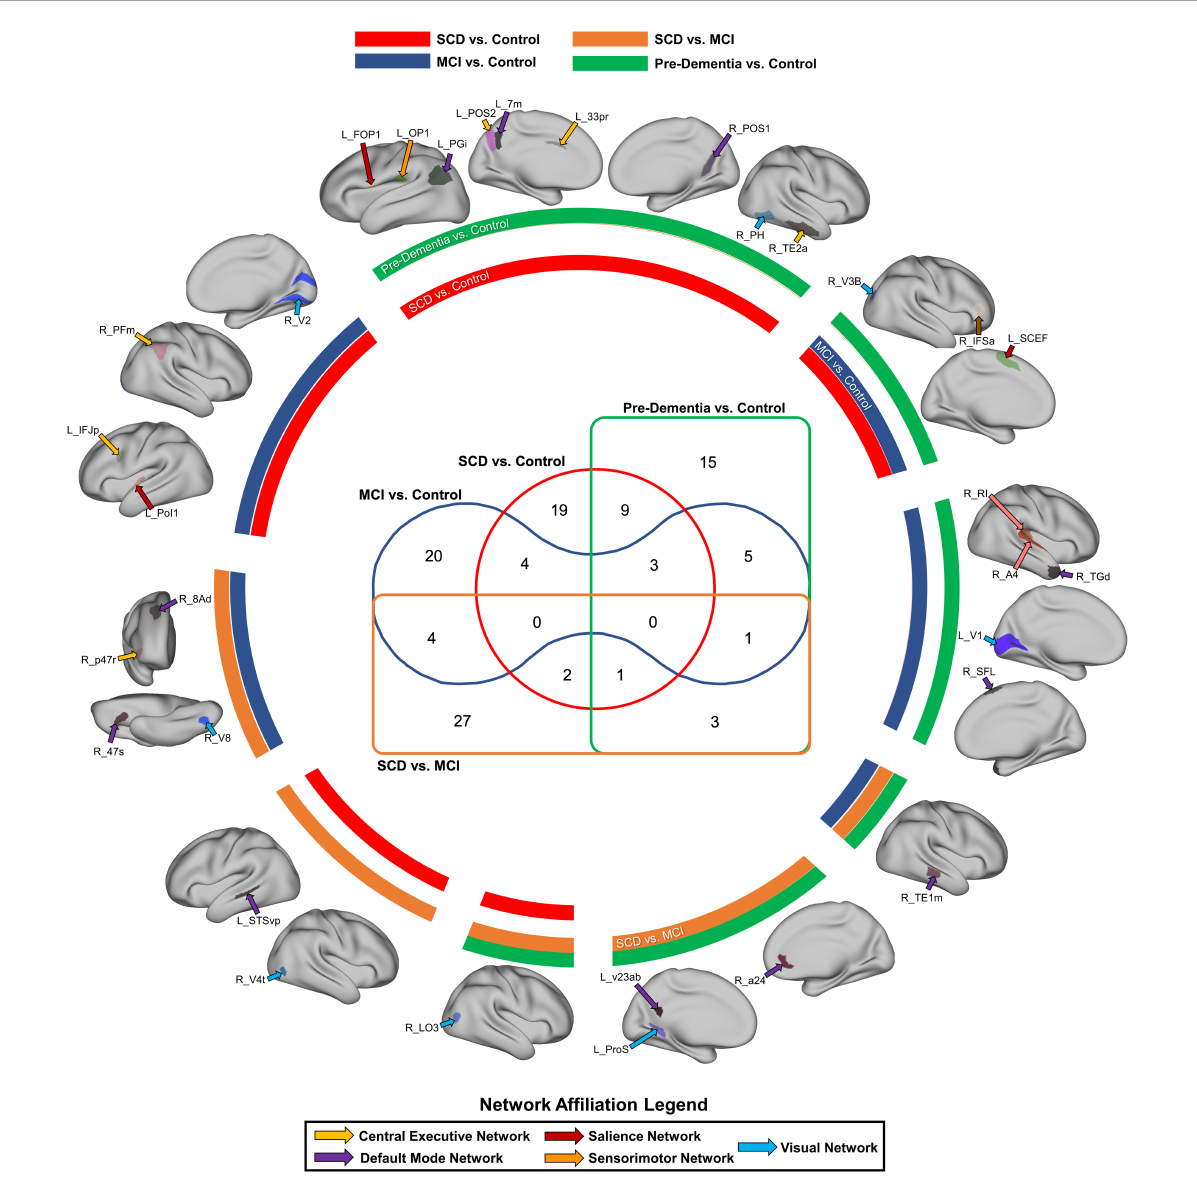
FIGURE2 Common parcels associated with at least two classification models. The color of the circular bands represents the associated model, with SCD vs. Control in red, MCI vs. control in blue, pre-dementia status (SCD + MCI) in green, and SCD vs. MCI in orange. The color of the arrows labeling each anatomical region also represents the network affiliated with each region, with a legend provided at the bottom of the figure. The Venn diagram in the middle signifies the number of parcels which are common to at least two